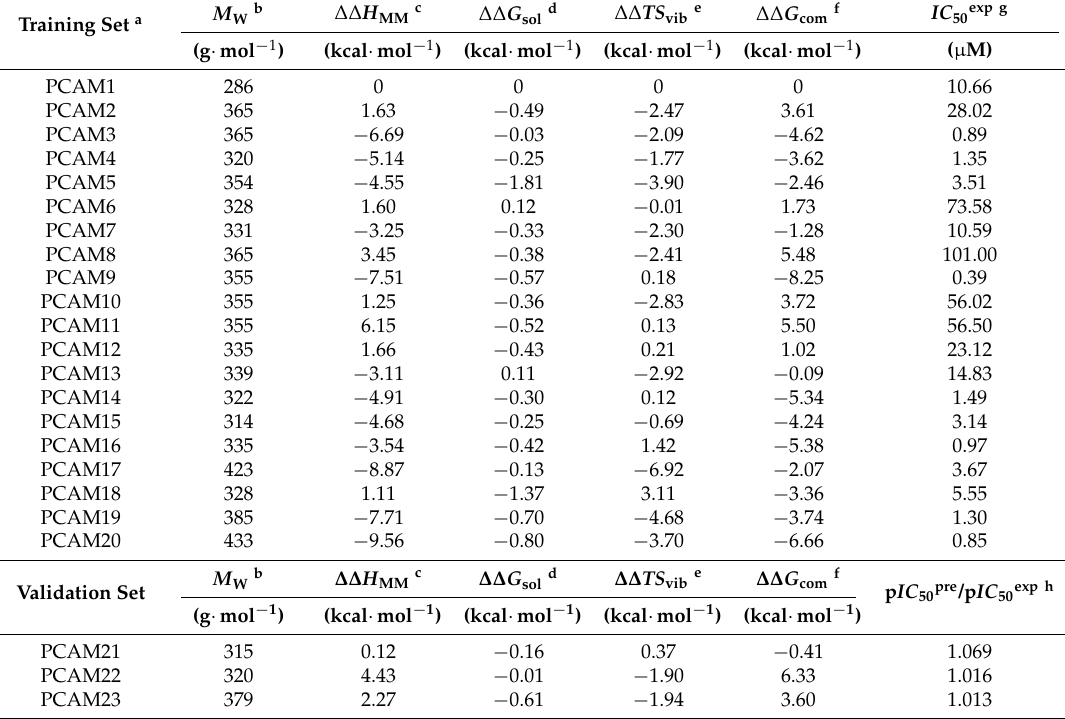
Table 2. Complexation Gibbs free energy (binding affinity) and its components for the training set of InhA inhibitors PCAM1-20 and validation set inhibitors